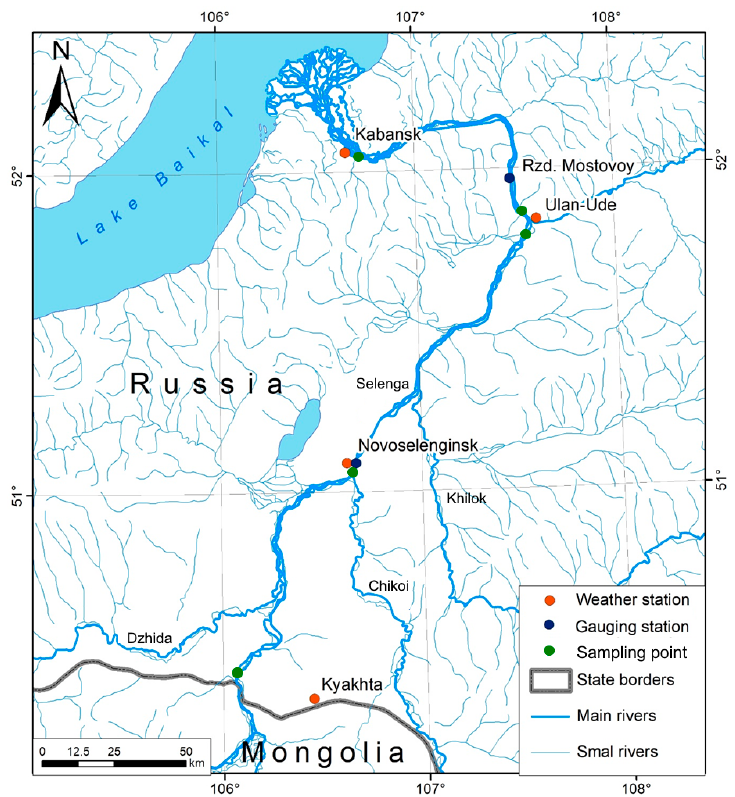
Figure 1. Location of the Selenga River basin, water gauge stations, meteorological stations, and sampling points on the territory of Russia.